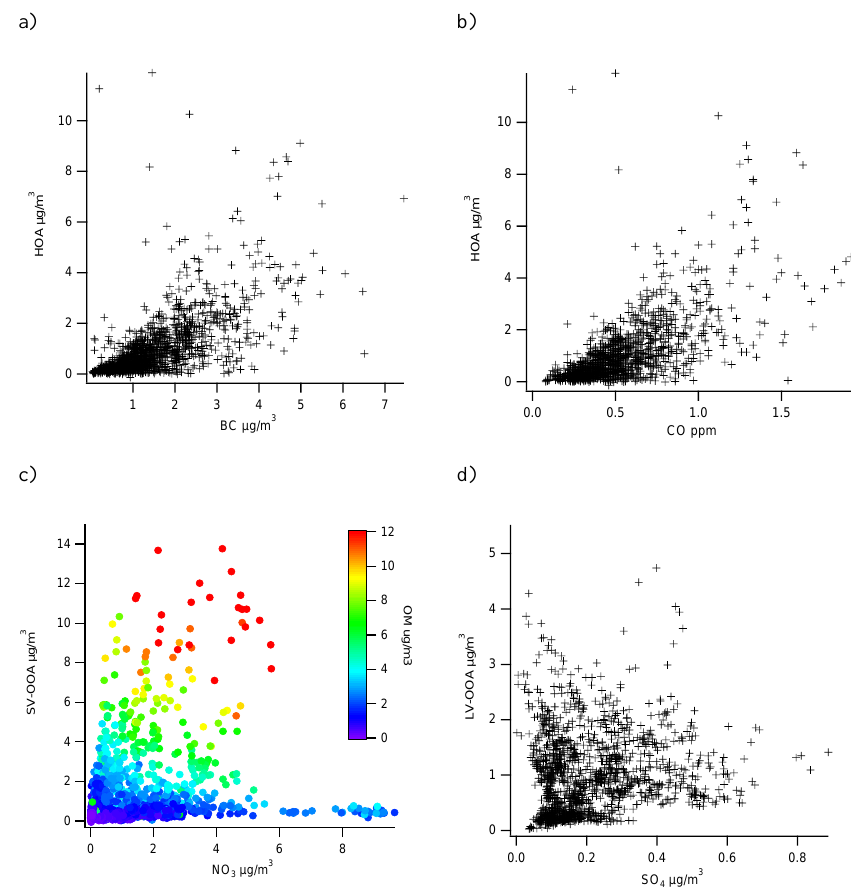
Fig. 9. Scatter plot comparisons of PMF factor contributions for: (a) HOA and BC; (b) HOA and CO; (c) SV-OOA and nitrate; and (d) Figure 9. Scatter plot comparisons of PMF factor contributions for: a) HOA and BC; b) HOA 1 LV-OOA and and CO; c) SV-OOA and nitrate; and d) LV-OOA and sulfate. 2